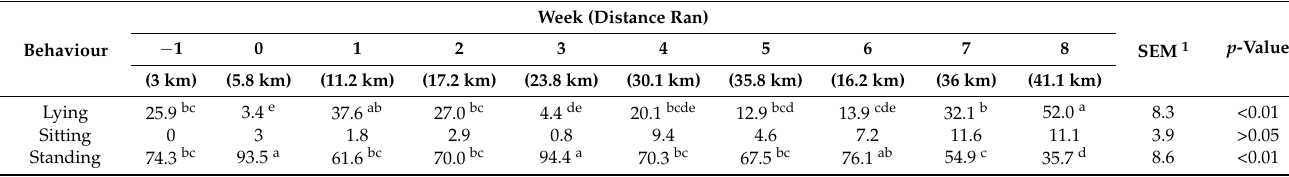
Table 4. Percent of time (%) spent performing observed behaviours on gangline during the 5-min post-exercise period for dogs undergoing 10 weeks of incremental conditioning.